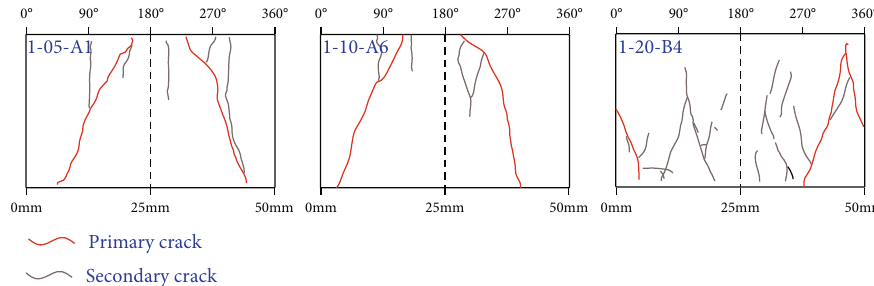
Figure 5: Sketch of fractures after failure of Scheme 1 under di ff erent con fi ning pressures.